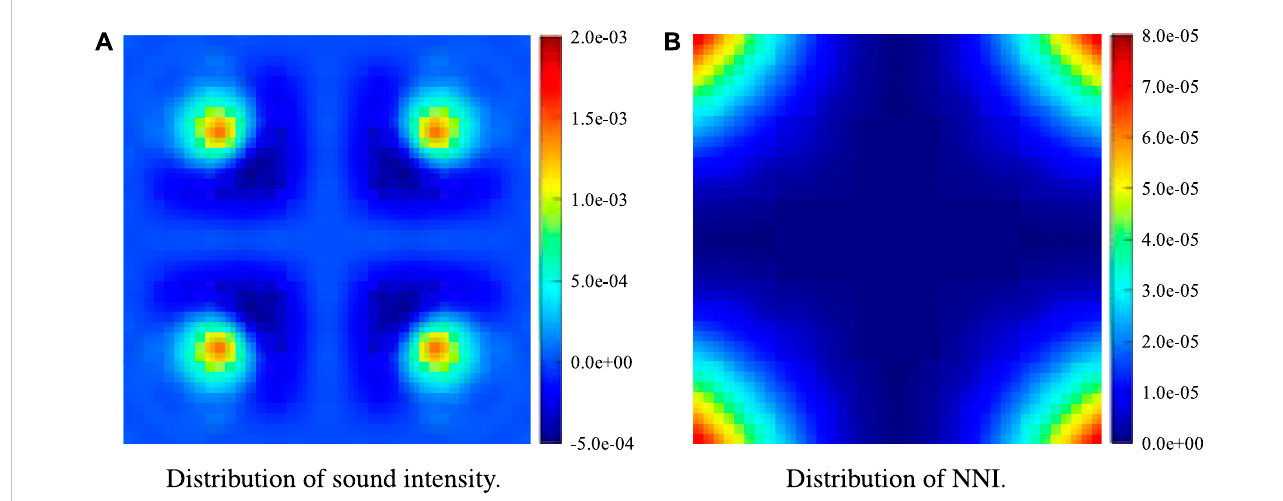
FIGURE 7 Distributions of sound intensity and NNI at 100 Hz. (A) Distribution of sound intensity. (B) Distribution of NNI.